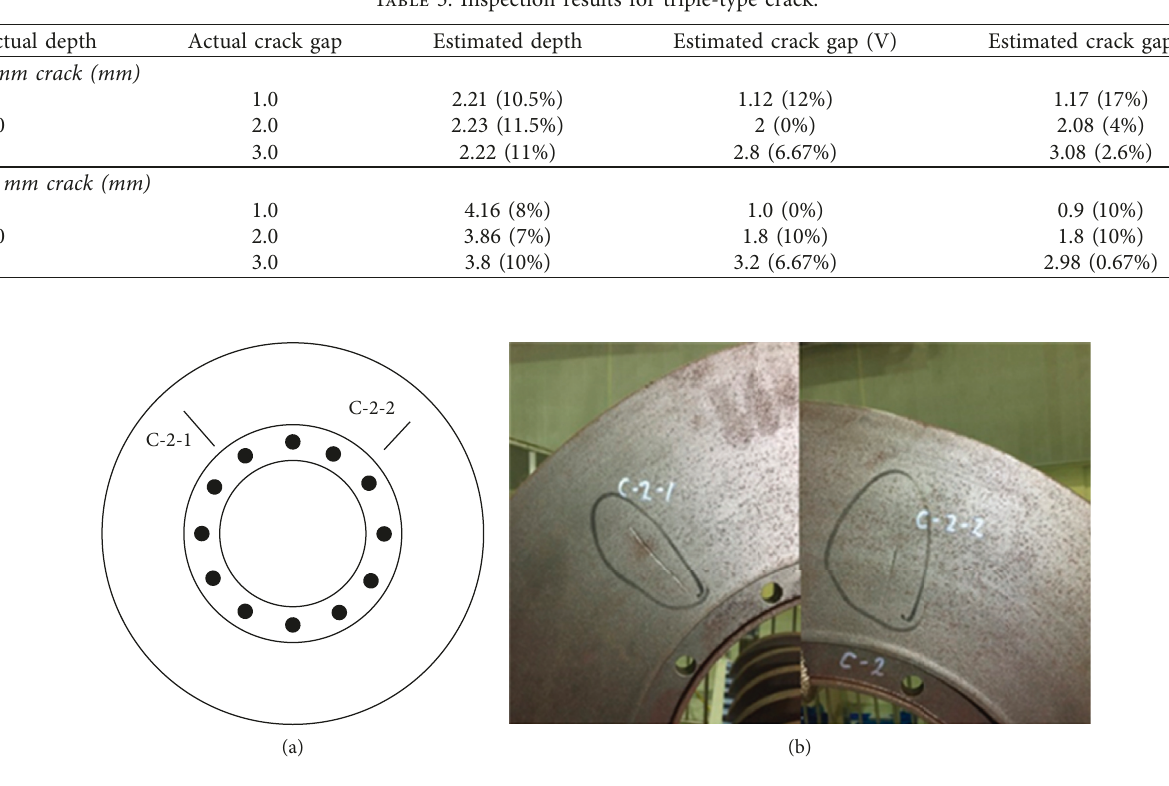
Figure 24: Natural crack in KTX brake disc: (a) crack location and (b) photograph.